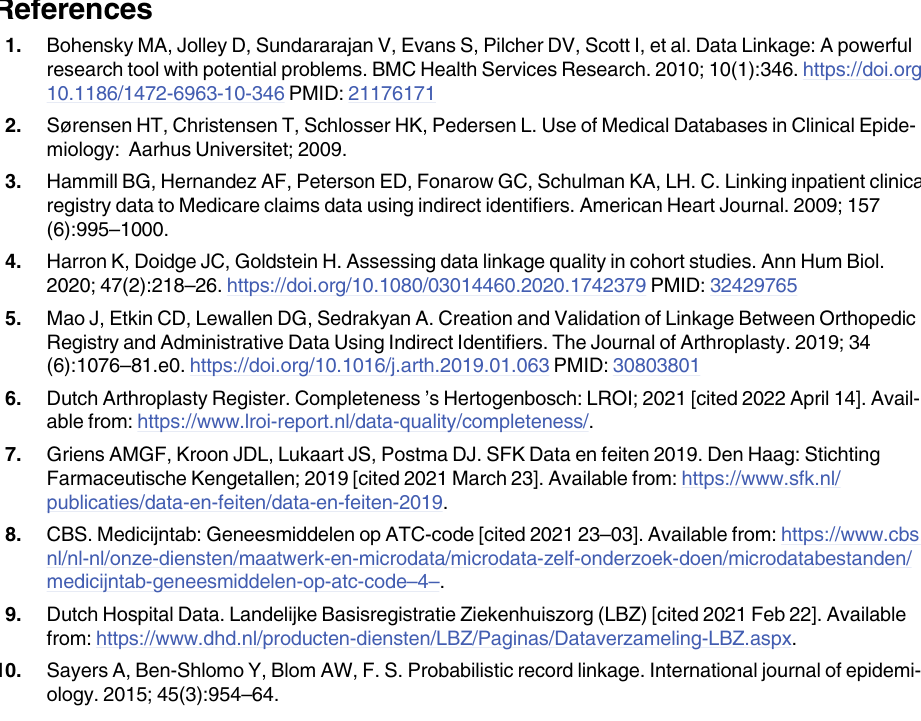
S2 Table. The selected revision arthroplasty population linked on low-molecular weight heparin and patient postcode compared to the not-linked